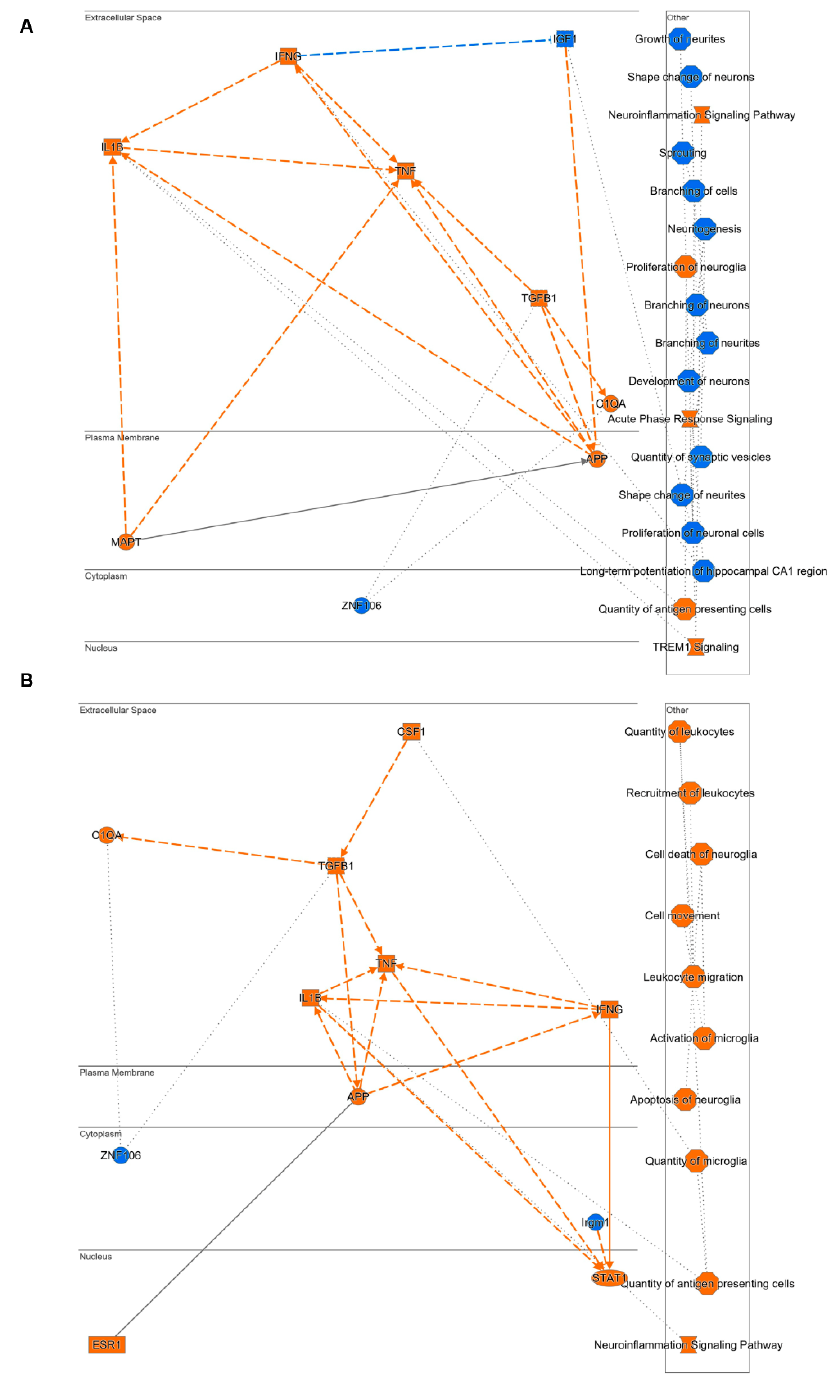
Figure 6. Generation of mechanistic hypothesis based on differential transcriptomic profiling obtained in Tg2576-vehicle vs. wild type-vehicle ( A ) and Tg2576-DHA vs. wild type-DHA ( B ) groups. The functional networks are based on a precomputed table containing inferred relationships between molecules, functions, diseases, and pathways obtained and scored by a machine learning algorithm operating entirely on prior knowledge. The heuristic graph algorithm present in IPA software was optimized to create a manageable network that brings together the most significantly activated (in orange; positive z-score) or inhibited (in blue; negative z-score) upstream regulators, diseases, functions and pathways from the differential RNA-seq datasets.